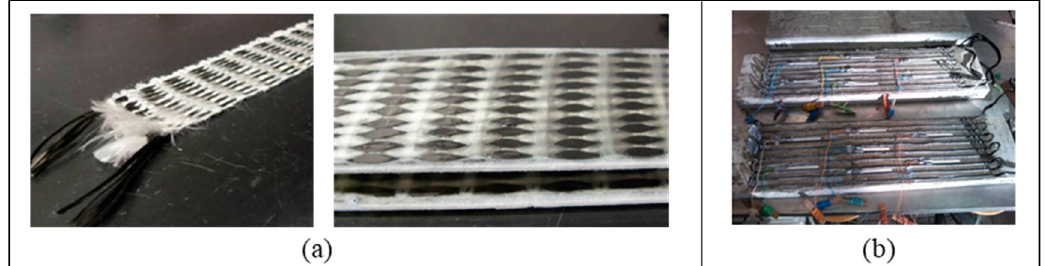
Figure 10. ( a ) textile-pattern strain sensor; ( b ) concrete specimens reinforced with carbon fiber epoxy resin composites [158] (open access, MDPI).